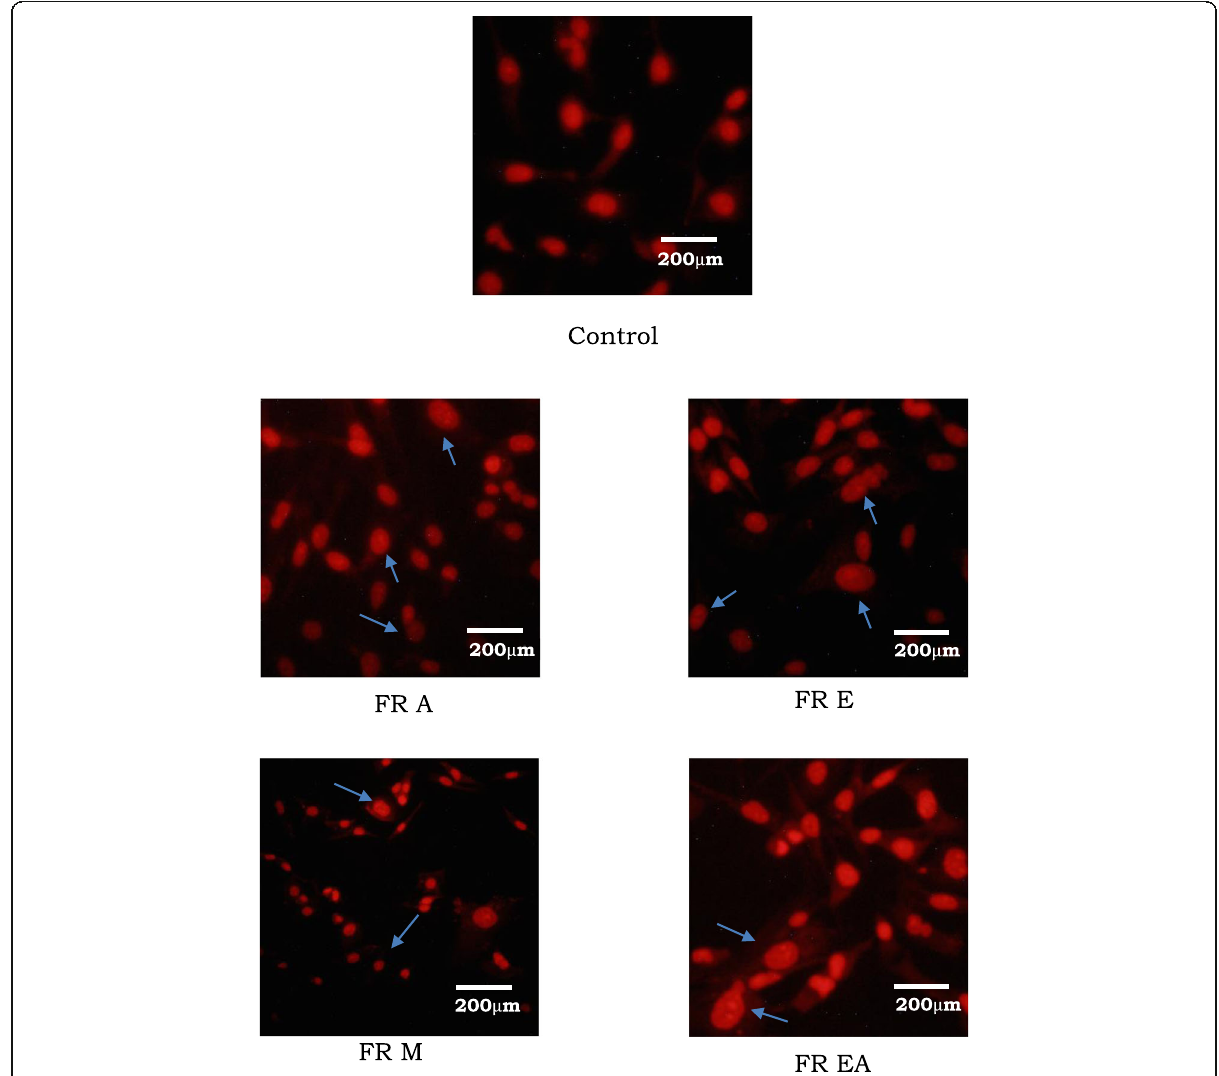
Fig. 4 Morphological changes observed in MDA MB 231 cells when treated with IC 50 concentrations of F. religiosa latex extracts along with control when stained with Propidium iodide. A — acetone; E — ethanol; M — methanol; EA — ethyl